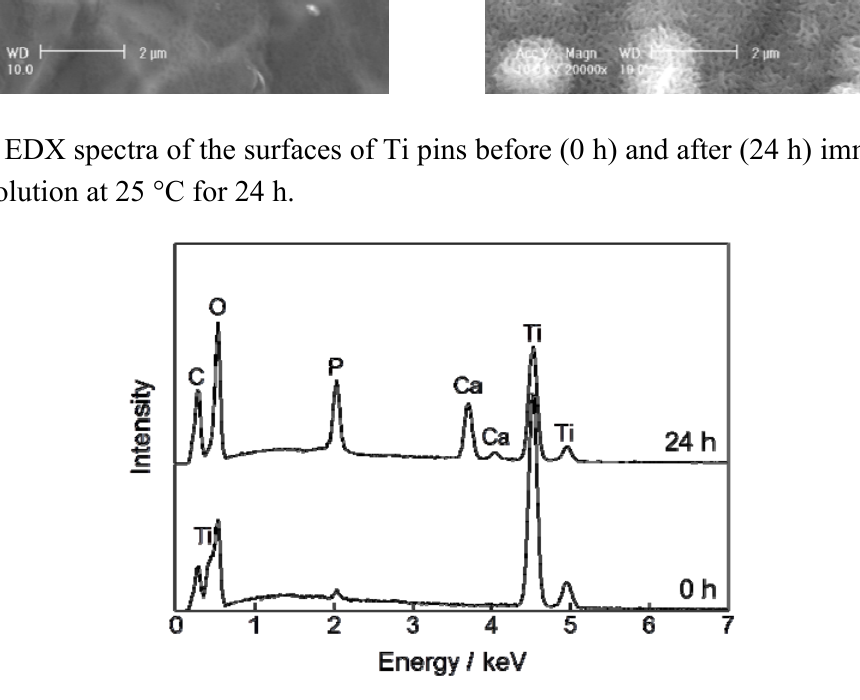
Figure 3. XRD pattern of calcium phosphate deposited on the Ti pin after immersion in the CaP solution at 25 °C for 24 h and that of a silicon-zero-background